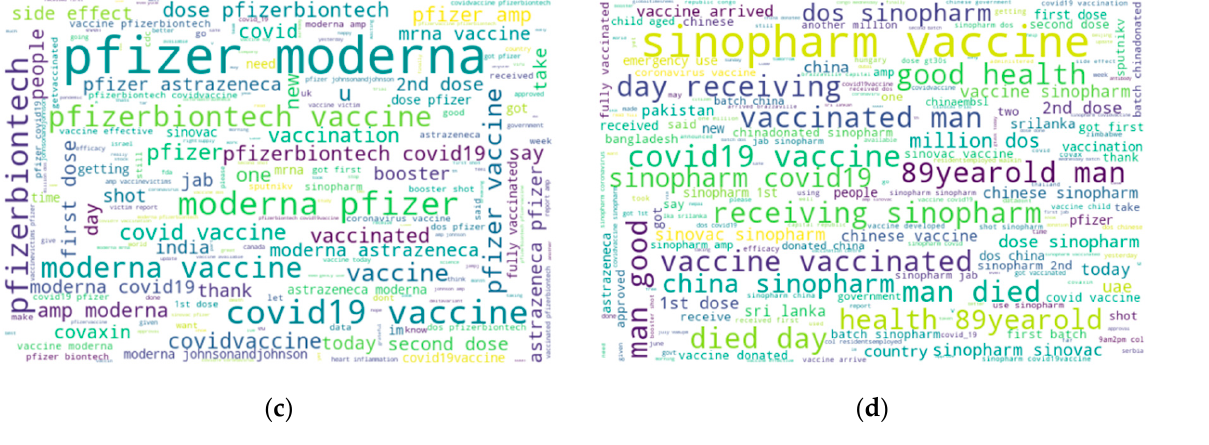
Figure 2. Word cloud of four different COVID-19 vaccines: ( a ) word cloud of Covaxin-related tweets; ( b ) word cloud of Moderna-related tweets; ( c ) word cloud of Pfizer-related tweets; ( d ) word cloud of Sinopharm-related tweets.